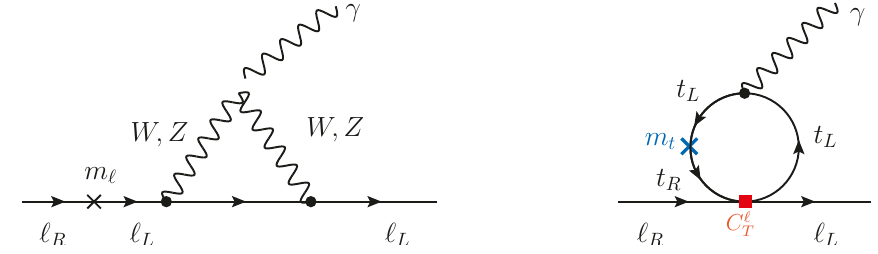
Figure 2 . One sample of electroweak contributions to lepton dipoles in the SM (left), compared to the NP contribution induced by the Lagrangian (2.2) at loop-level (right). The factor m ‘ of the SM rates is replaced by m t , thus compensating the loop suppression and inducing a large contribution to leptonic dipoles.